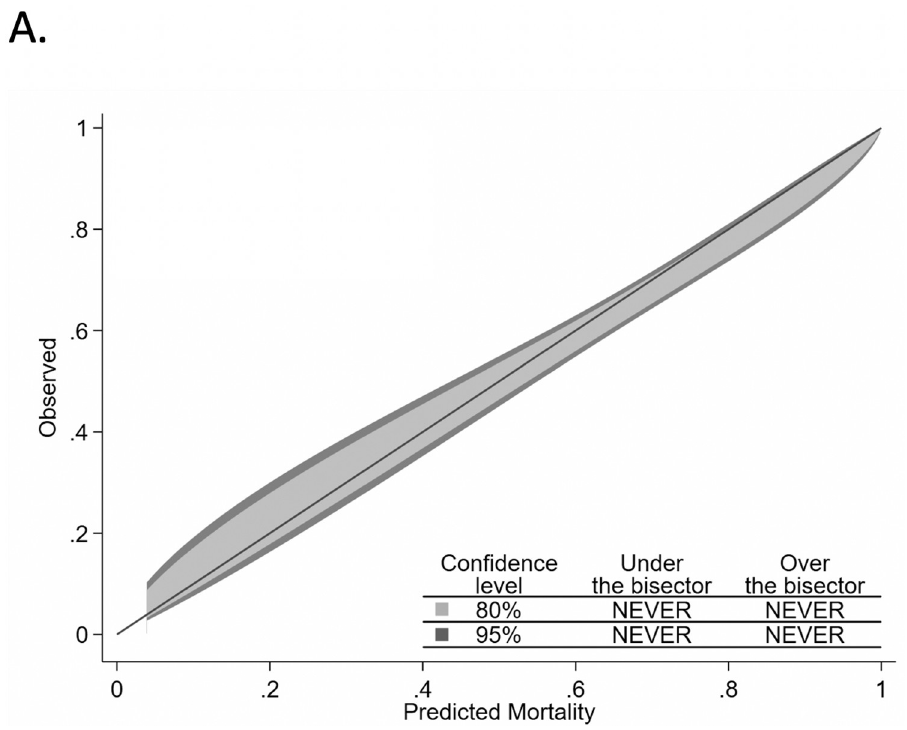
Fig 2. Comparative calibration belt plots for